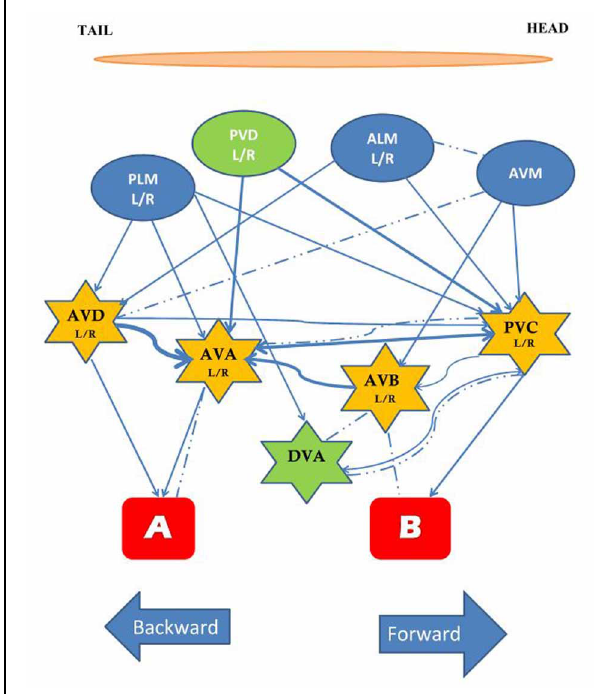
FIGURE 1 | The circuit mediating the response to tap. The touch cells are represented by ovals (blue), the interneurons by stars (yellow), and the motor neurons by rectangles (red). All neurons are bilaterally symmetrical, except AVM and DVA. The neurons in green, PVD and DVA, contribute to both forward and backward movement and may play a role in integrating the two responses. Arrows and dashed lines denote chemical and electrical connections, respectively, thickness of lines reflects relative number of synapses [Based on data from Chalfie et al. (1985), Wicks and Rankin